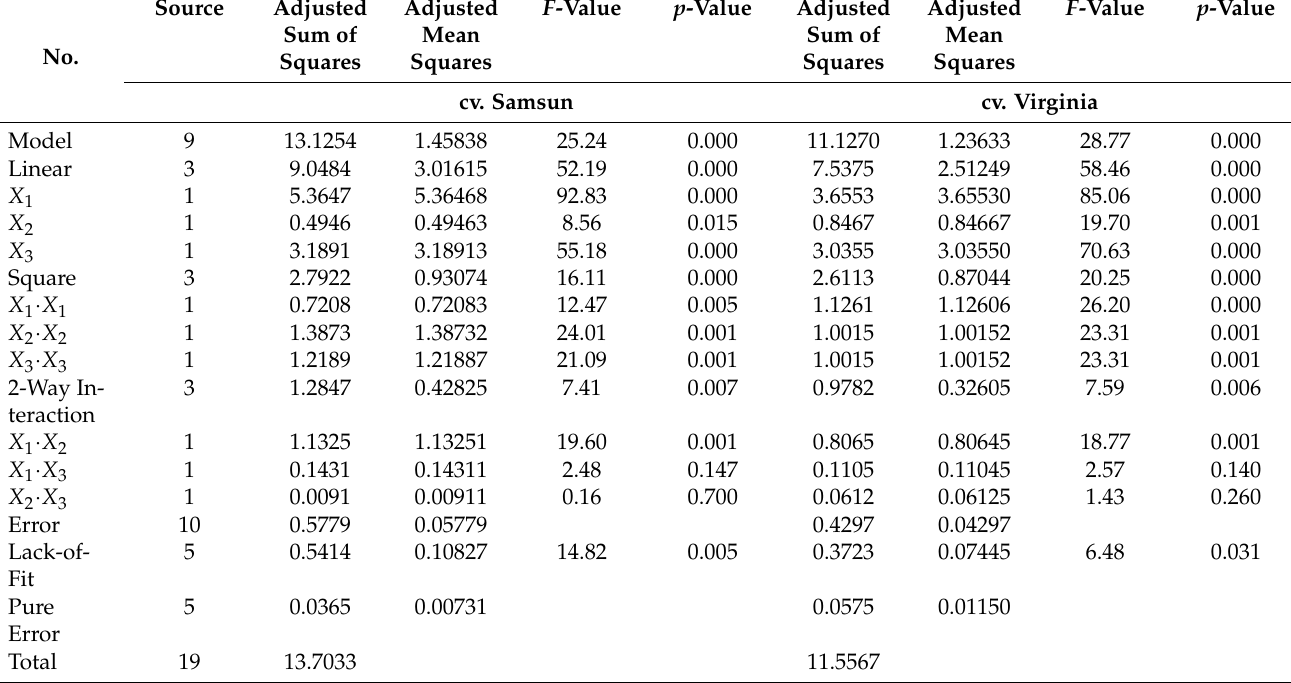
The surface response plots for the effect of independent variables on the N. tabacum cv. Samsun leaves total extraction yield [%] are depicted in Figure 1.